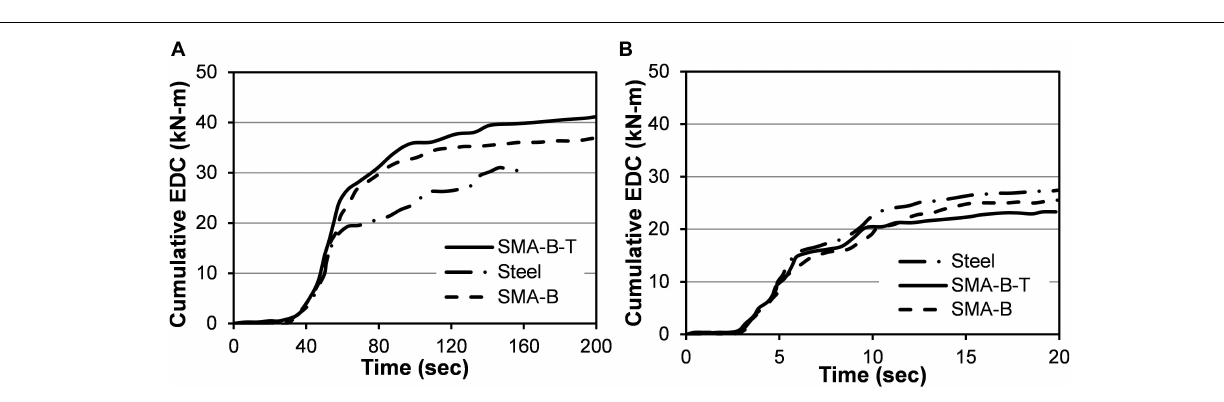
FIGURE 15 | Average cumulative energy dissipation of three bridge bents under (A) long duration and (B) spectrally equivalent short duration